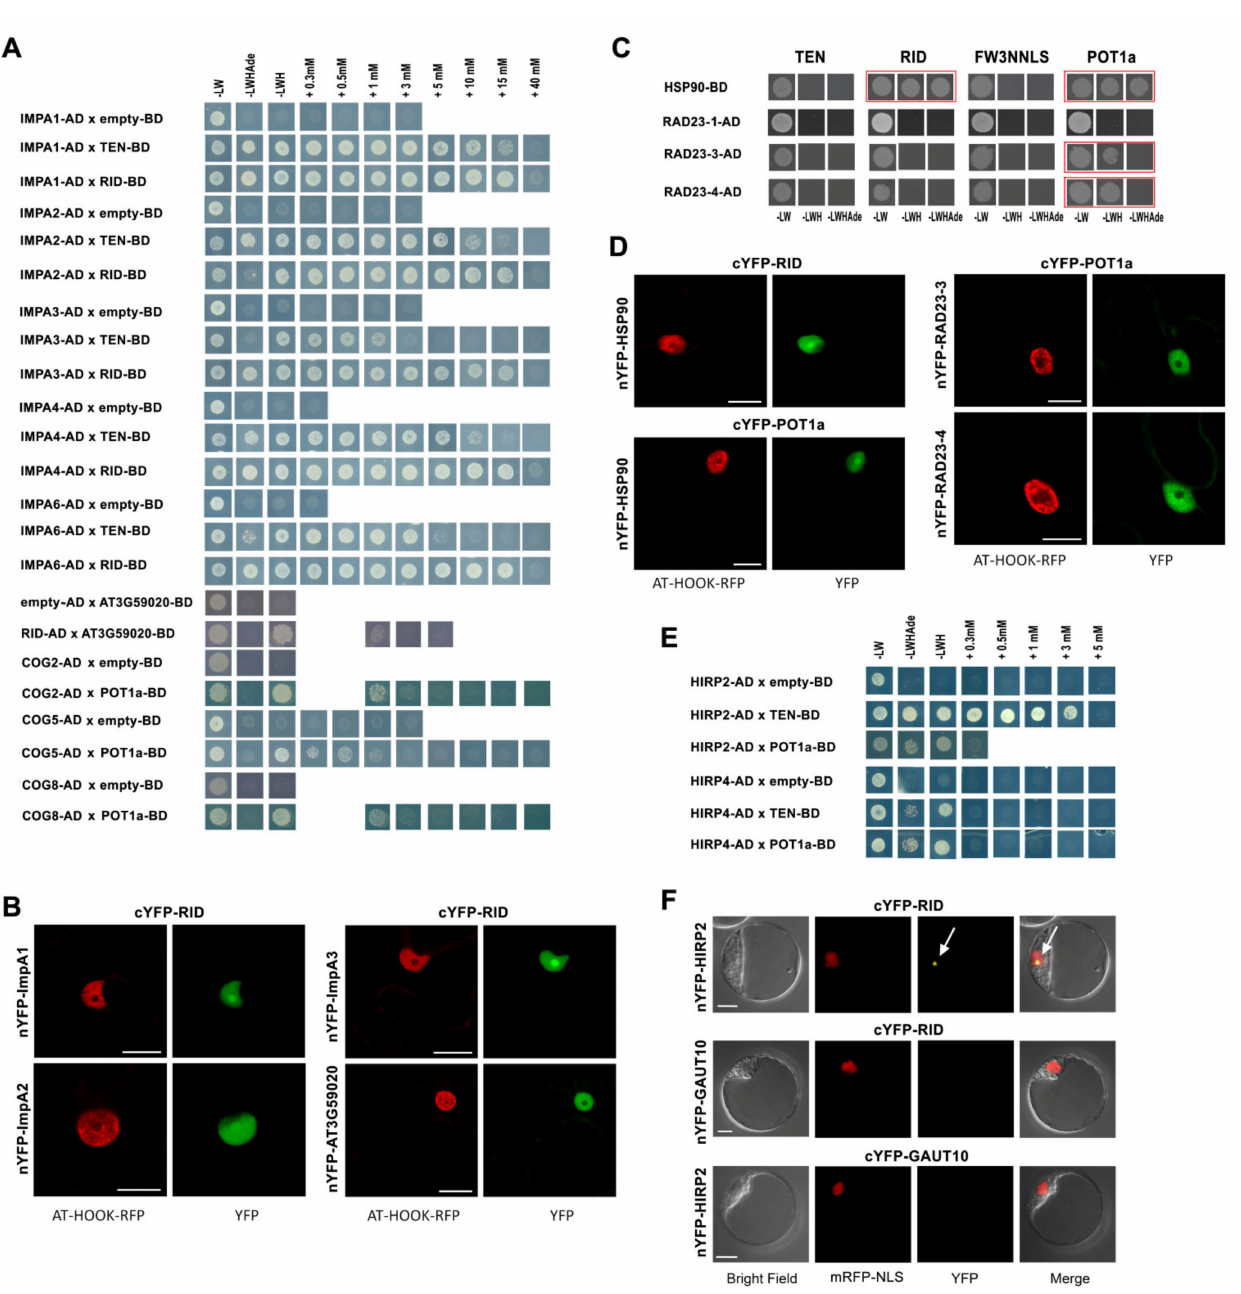
Figure 5. Interactions of AtTERT and POT1a with proteins involved in protein transport and folding. ( A ) Strong positive interactions of N-terminal AtTERT constructs (TEN, RID) with the importin alpha family proteins (ImpA1, ImpA2, ImpA3, ImpA4, ImpA6) were detected in Y2H assays on –LWHAde selective plates and –LWH selective plates supplemented with 3-aminotriazol up to 40 mM. Weak interactions of the importin beta family protein AT3G59020 with the RID construct and three components of the oligomeric Golgi complex (COG2, COG5 and COG8) showed positive interactions with the POT1a protein exclusively. ( B ) Using the BiFC assay, the nYFP-ImpA1, ImpA2, ImpA3 and constructs confirmed positive nuclear and nucleolar interaction with cYFP-RID in N. benthamiana leaves. AT3G59020 interaction with RID was localized in the nucleus. ( B , D ) YFP, yellow fluorescence, AT-HOOK-RFP (red) was used to label nuclei in N. benthamiana leaves, the cYFP -GAUT10 construct served as a negative control (see Figure S4B), scale bars are 20 µ m. ( C , D ) Positive interactions of foldosome (HSP90) and proteasome substrate delivery proteins (RAD23-3, RAD23-4) with RID